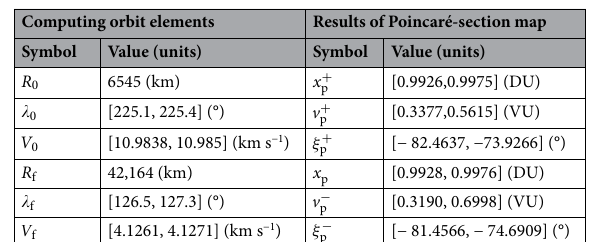
Table 2. The orbital elements of plotting the Poincaré section.